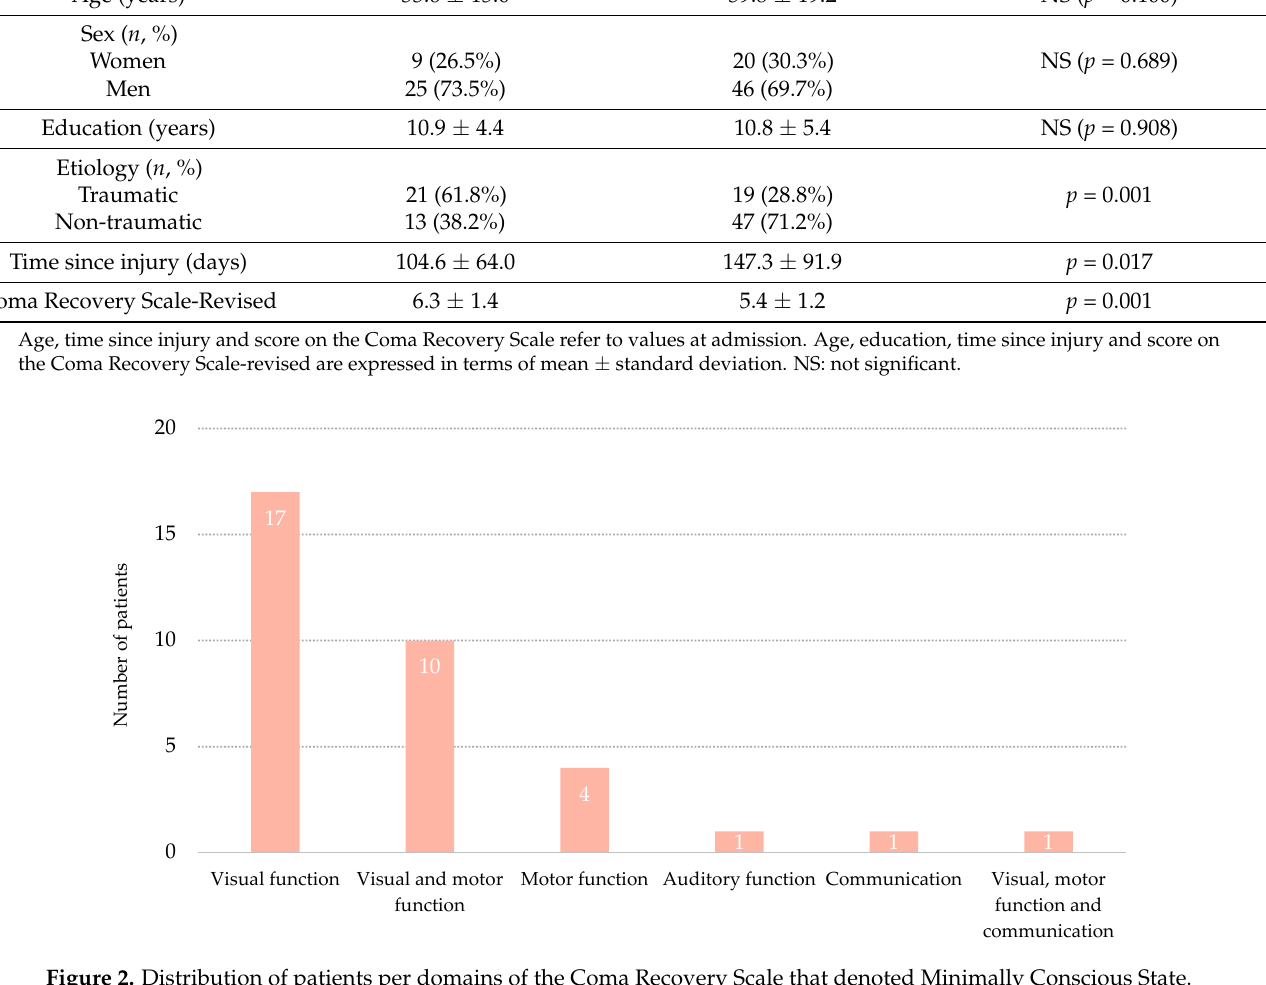
Figure 2. Distribution of patients per domains of the Coma Recovery Scale that denoted Minimally Conscious State.